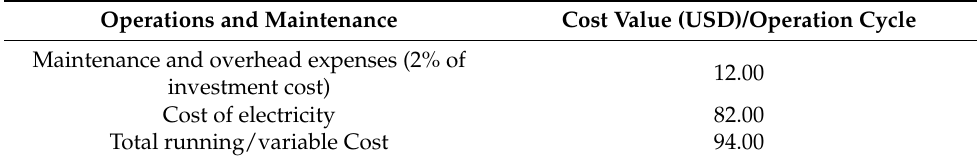
Table 4. Operation and maintenance cost of running the drying system.